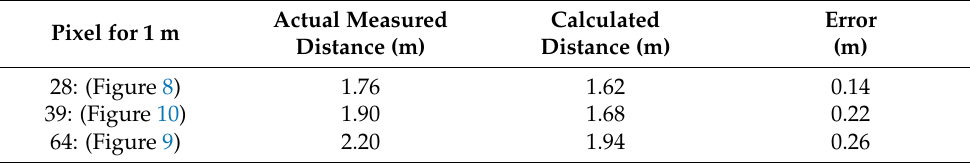
Table 8. Target position measurements and comparison with actual values. Pixel for 1